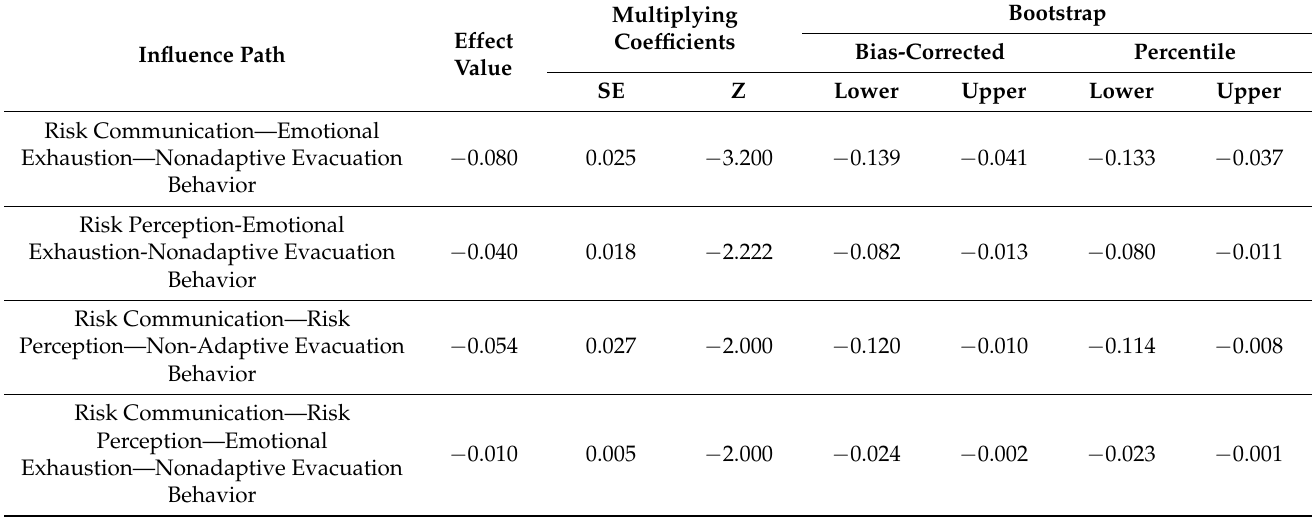
Table 6. Mediation